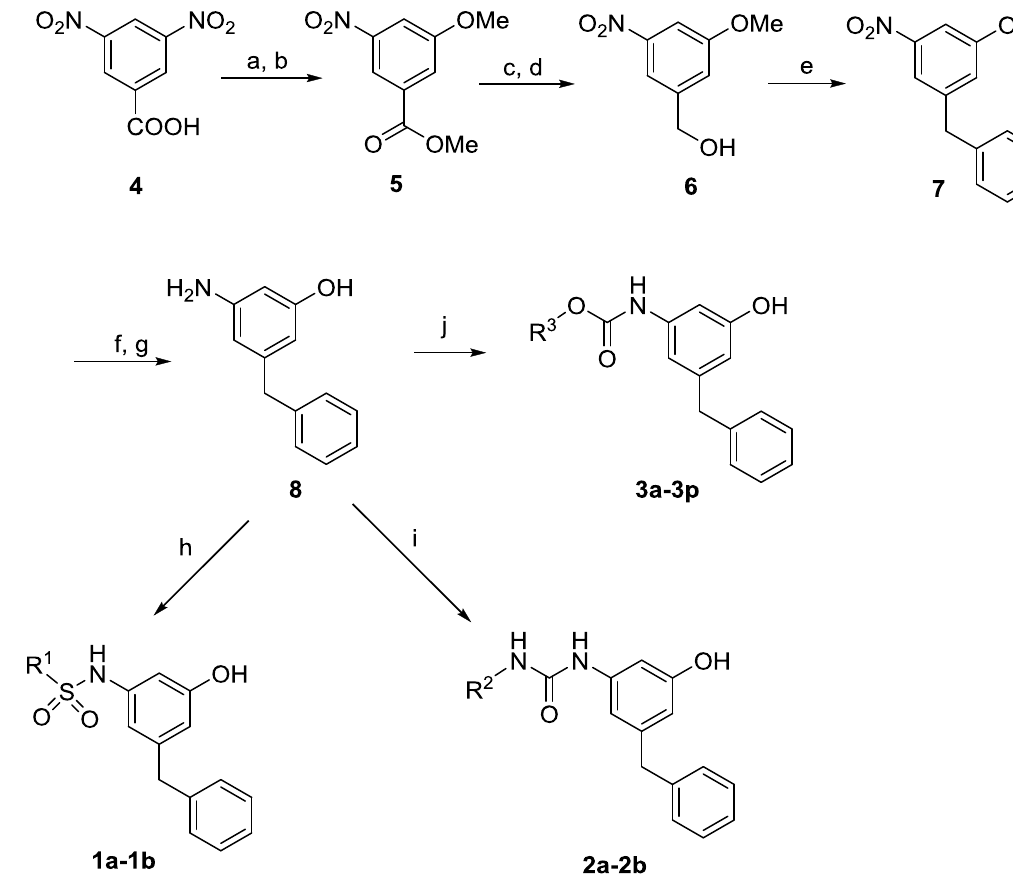
Table 1. Inhibitory activity of 1a – 1b and 2a – 2b against Mtb